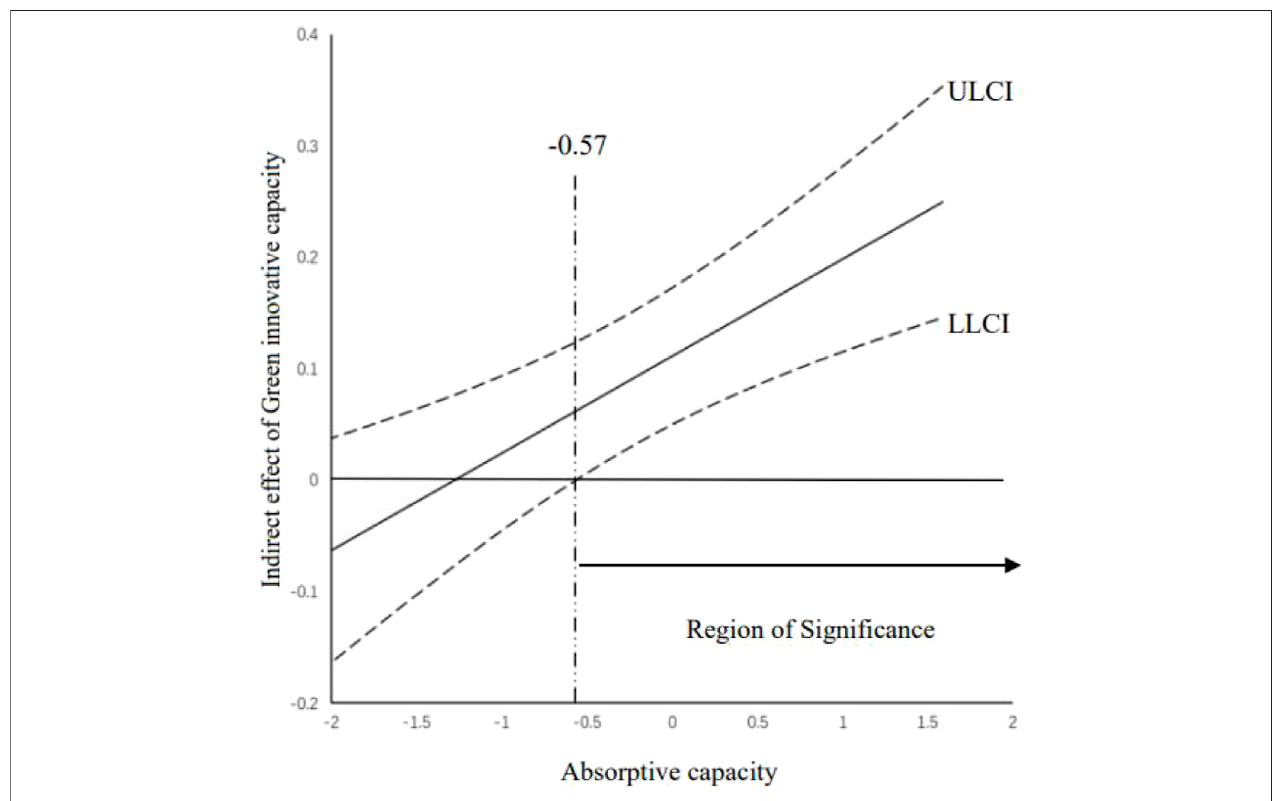
FIGURE 5 | The Moderated mediation effect